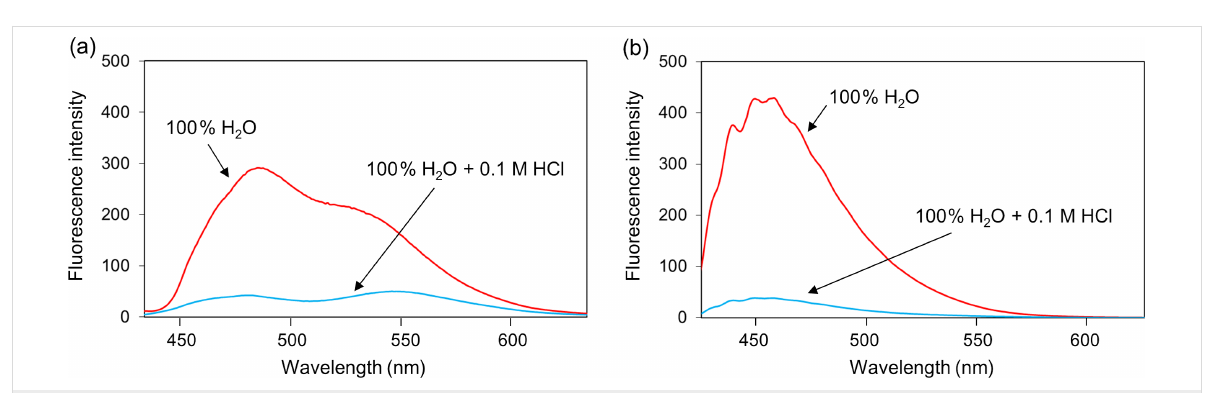
Figure 3: Fluorescence spectral changes of (a) 4a (10 − 5 M, Ex max = 413 nm) and (b) 4e (10 − 5 M, Ex max = 415 nm) upon addition of 0.1 M HCl.